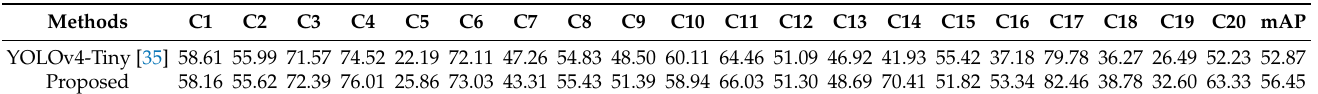
Table 12. Measured detection results on the DIOR dataset.